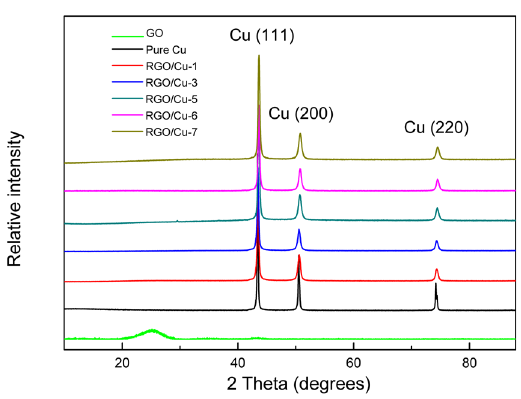
Figure 4. XRD patterns of the RGO, pure Cu and RGO/Cu